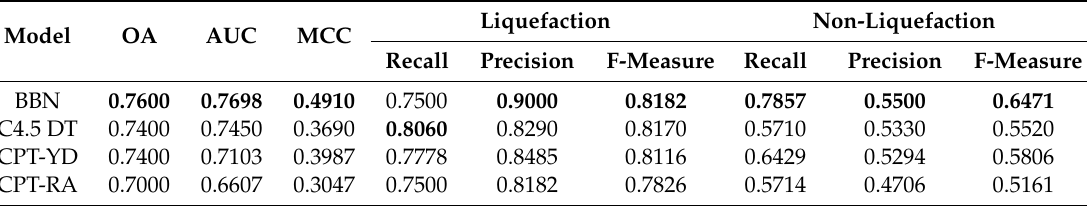
Table 6. Predictive performance evaluation of the testing